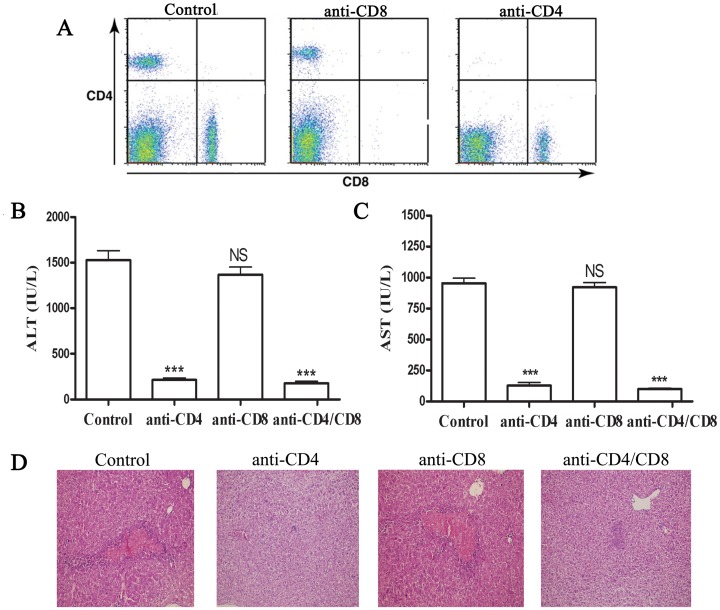
T cells and Con A-induced hepatitis.Isotype, CD4 and/or CD8 mAbs (100 µg per mouse) was administrated i.p. to Balb/c mice (n = 8 per group) 24h before Con A injection (20 mg kg–1). The effect of anti-CD4 orCD-8 antibodies administration on depleting these cells in the liver of mice prior injecting Con A was determined by FACS. Representative results were shown in (A). Sera were collected 24 h after Con A injection. Serum ALT (B) and AST (C) levels were measured. The results were presented as the mean ± SD of three separate experiments. ***, p<0.001 vs control. (D) The livers were removed 24 h later. Paraffin sections were stained with hematoxylin and eosin (H&E) staining. Representative liver sections were shown for each group, original magnification: ×200.